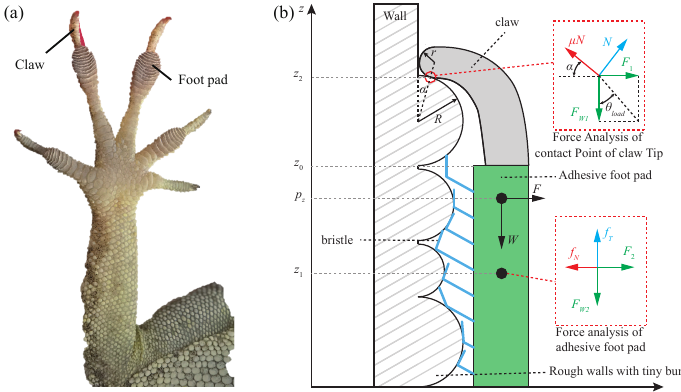
Figure 1. ( a ) Photograph and ( b ) adhesion model of the toe of an anole